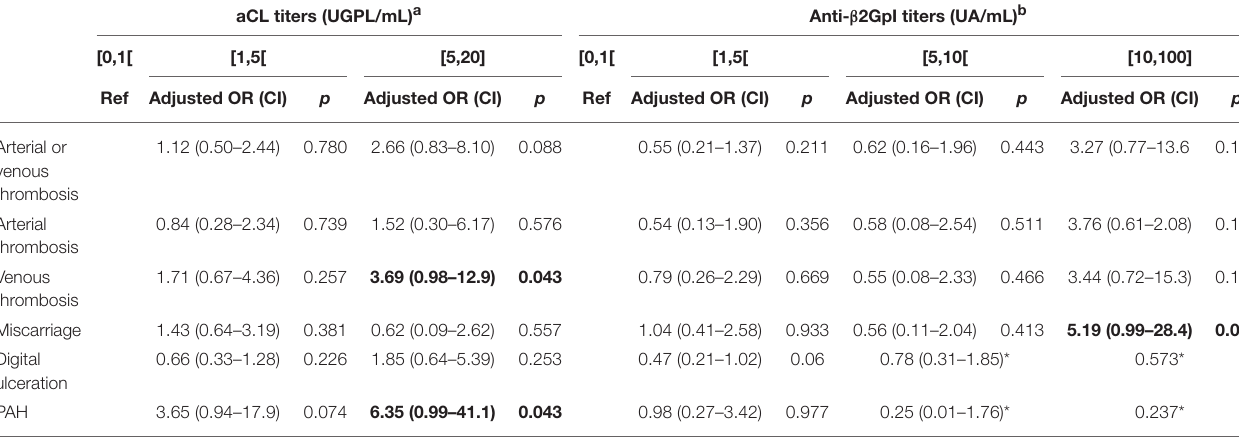
TABLE 4 | Multivariate comparisons of associations between aCL and anti- β 2GpI titers and clinical manifestations.